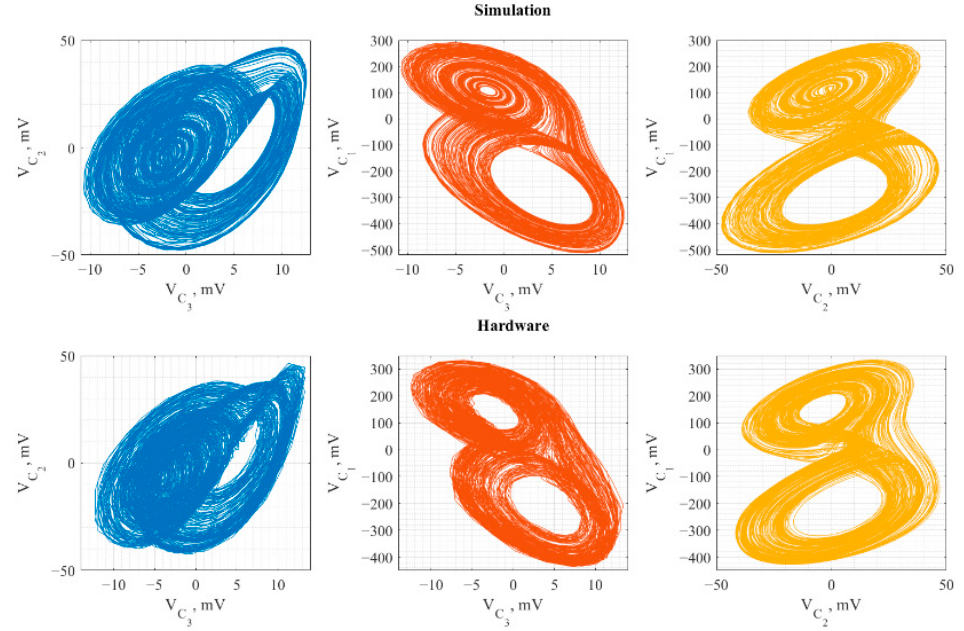
Figure 7. RC two-transistor chaos oscillator simulation ( top row ) and hardware ( bottom row ) two- dimensional projection.